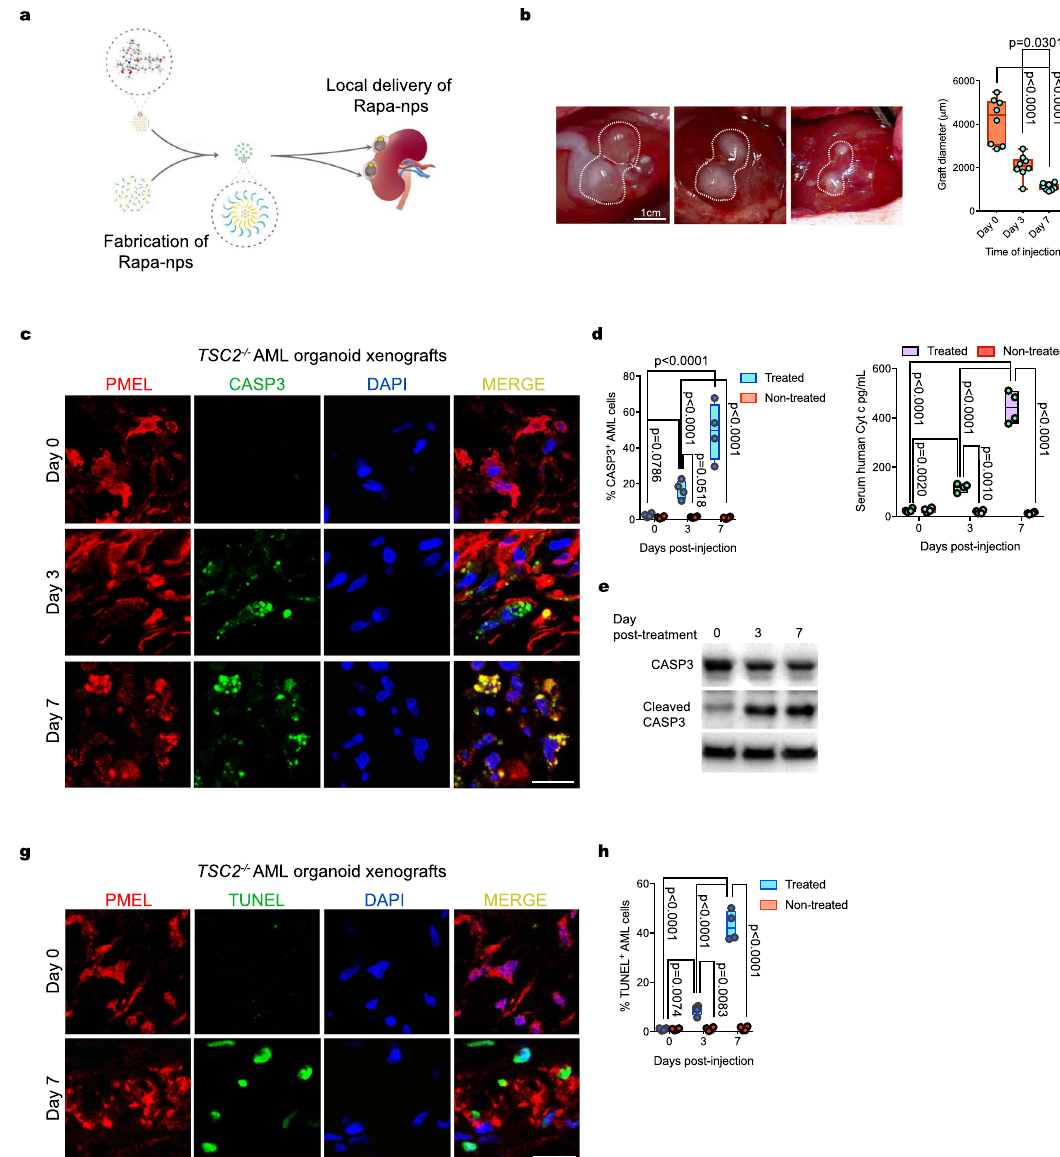
Fig. 6 Ablation of TSC2 − / − AML organoid xenografts treated with Rapamycin-loaded nanoparticles. a Schematic showing the strategy for the delivery of Rapa-nanoparticles locally, near the TSC2 − / − AML organoid xenografts. b Representative photographs showing the size of TSC2 − / − xenografts on Day 3 and Day 7 post Rapa-Np delivery. Quanti fi ed diameter values on the fl oating bar graph represent mean ± SD, n = 8 grafts. P values for individual comparisons done using Tukey test in one-way ANOVA analysis are indicated. c Representative immuno fl uorescence images for the detection of activated Casp3 in TSC2 − / − AML organoid xenograft PMEL + myoid cells on Day 3 and Day 7 postdrug delivery. Five independent experiments were performed with similar results. d Floating bar graph with quanti fi cation of PMEL + Casp3 + cells on Days 3 and 7 postdrug delivery. Mean ± SD are reported, n = 4 grafts. P values determined by two-way ANOVA analysis using Tukey test for multiple comparisons are indicated. e Detection of cleaved Casp3 on Day 0 (free organoid), 3 and 7 in protein extracts from TSC2 − / − AML xenografts (Day 3 and 7). f Quanti fi cation of human Cytochrome C in the serum of RNU carrying rats TSC2 − / − AML organoid xenografts, treated with Rapa-Np and controls that did not receive the treatment. Floating bar graph shows mean ± SD, n = 4 rats per group. P values determined by two-way ANOVA analysis using Tukey test for multiple comparisons are indicated. g Representative confocal imaging depicting detection of DNA fragmentation by TUNEL on sections of TSC2 − / − AML xenografts, three and seven days post Rapa-Np delivery. Five independent experiments were performed with similar results. h Floating bar graph for the quanti fi cation of PMEL + TUNEL + cells shows mean ± SD are reported, n = 4 grafts per group. P values determined by two-way ANOVA analysis using Tukey test for multiple comparisons are indicated. Scale bars, 1 cm ( b ), 25 mm ( c , g